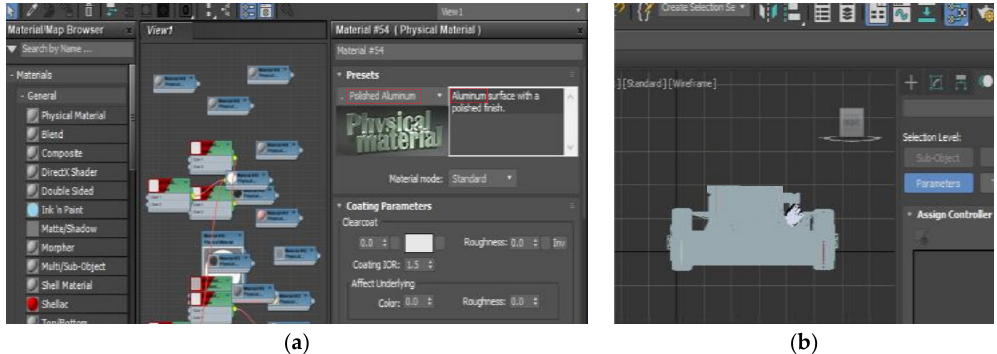
Figure 2. Virtual modeling with material map browser: ( a ) assigning materials to virtual components; ( b ) rendering of robotic vehicle from wireframe after the components were “materialized”.